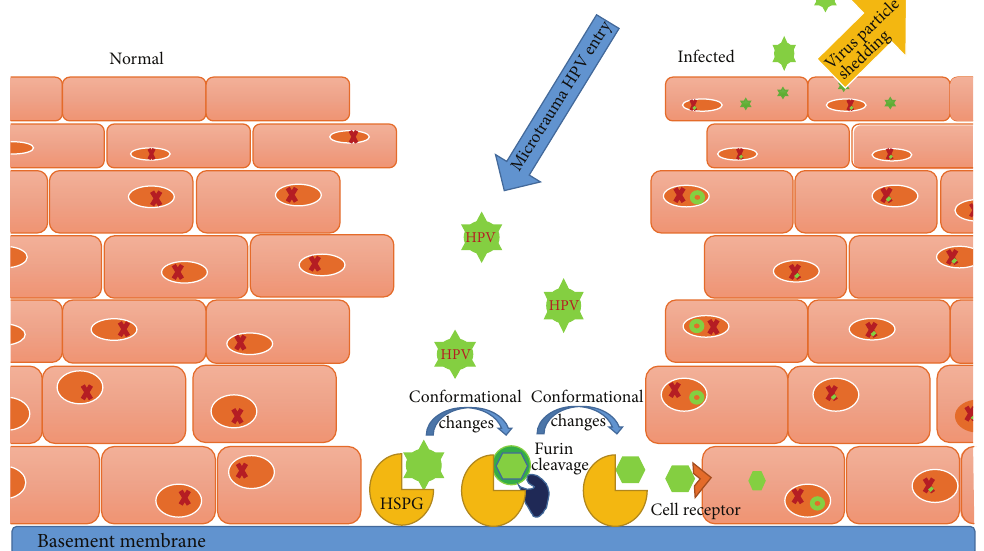
Figure 1: HPV reaches the basement membrane of the cervix through microtrauma. Interaction with HSPG via L1 protein induces conformational changes on the virus capsid, followed by furin cleavage and revealing of the binding site for the cell